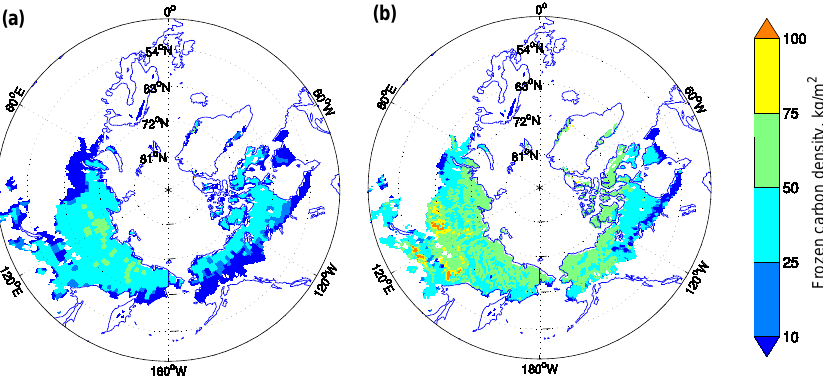
Figure 5. The frozen carbon maps obtained assuming a uniform frozen carbon distribution at the initial time step, and averaged over 5 years at the end of the steady-state run: (a) from Schaefer et al. (2011), and (b) from the current run, correspondingly.